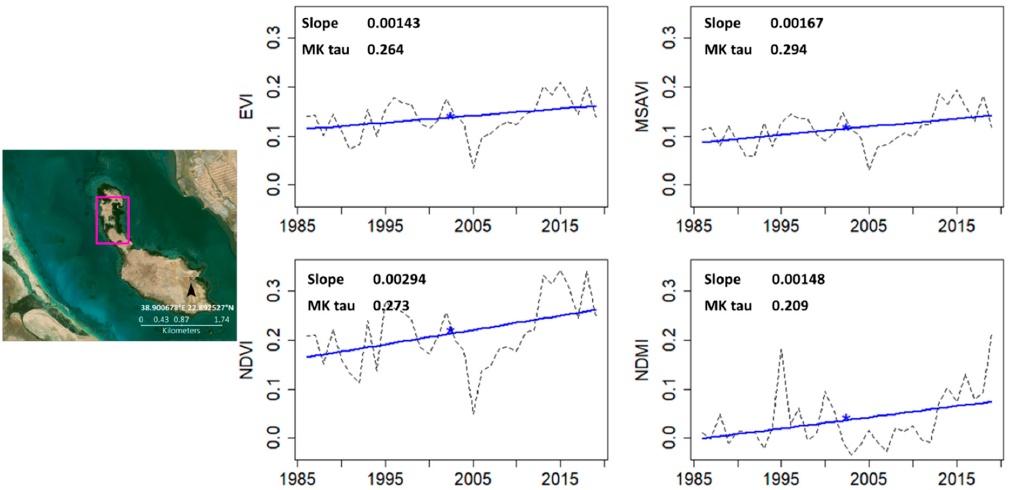
Figure 14. Trend (blue line) analysis for site in the south (enclosed in pink box). The symbol * shows the trend is significant, with one * meaning p value of equal or less than 0.05.